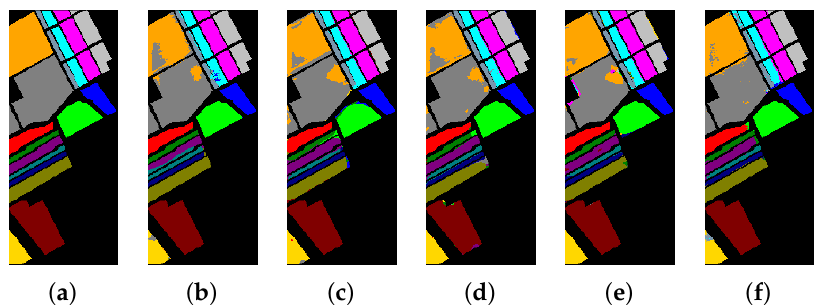
Figure 13. The classification maps of Salinas. ( a ) Ground-truth map. ( b )–( f ) Classification results of